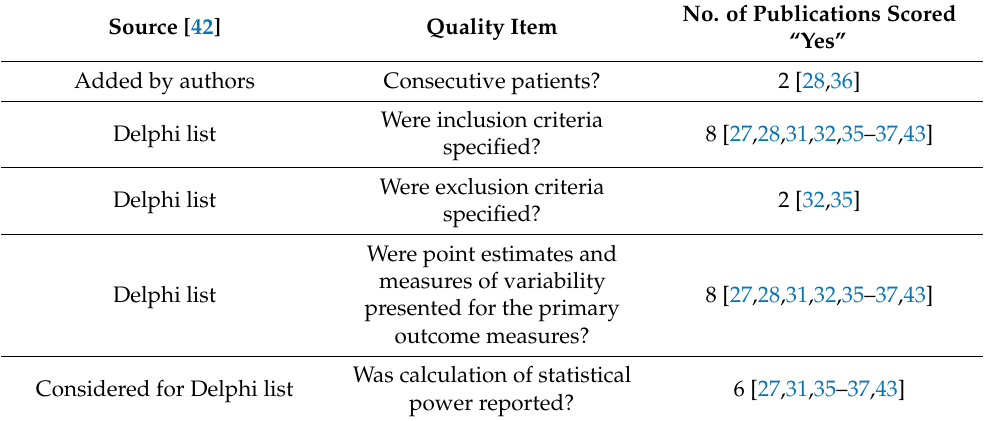
Table 2. Quality